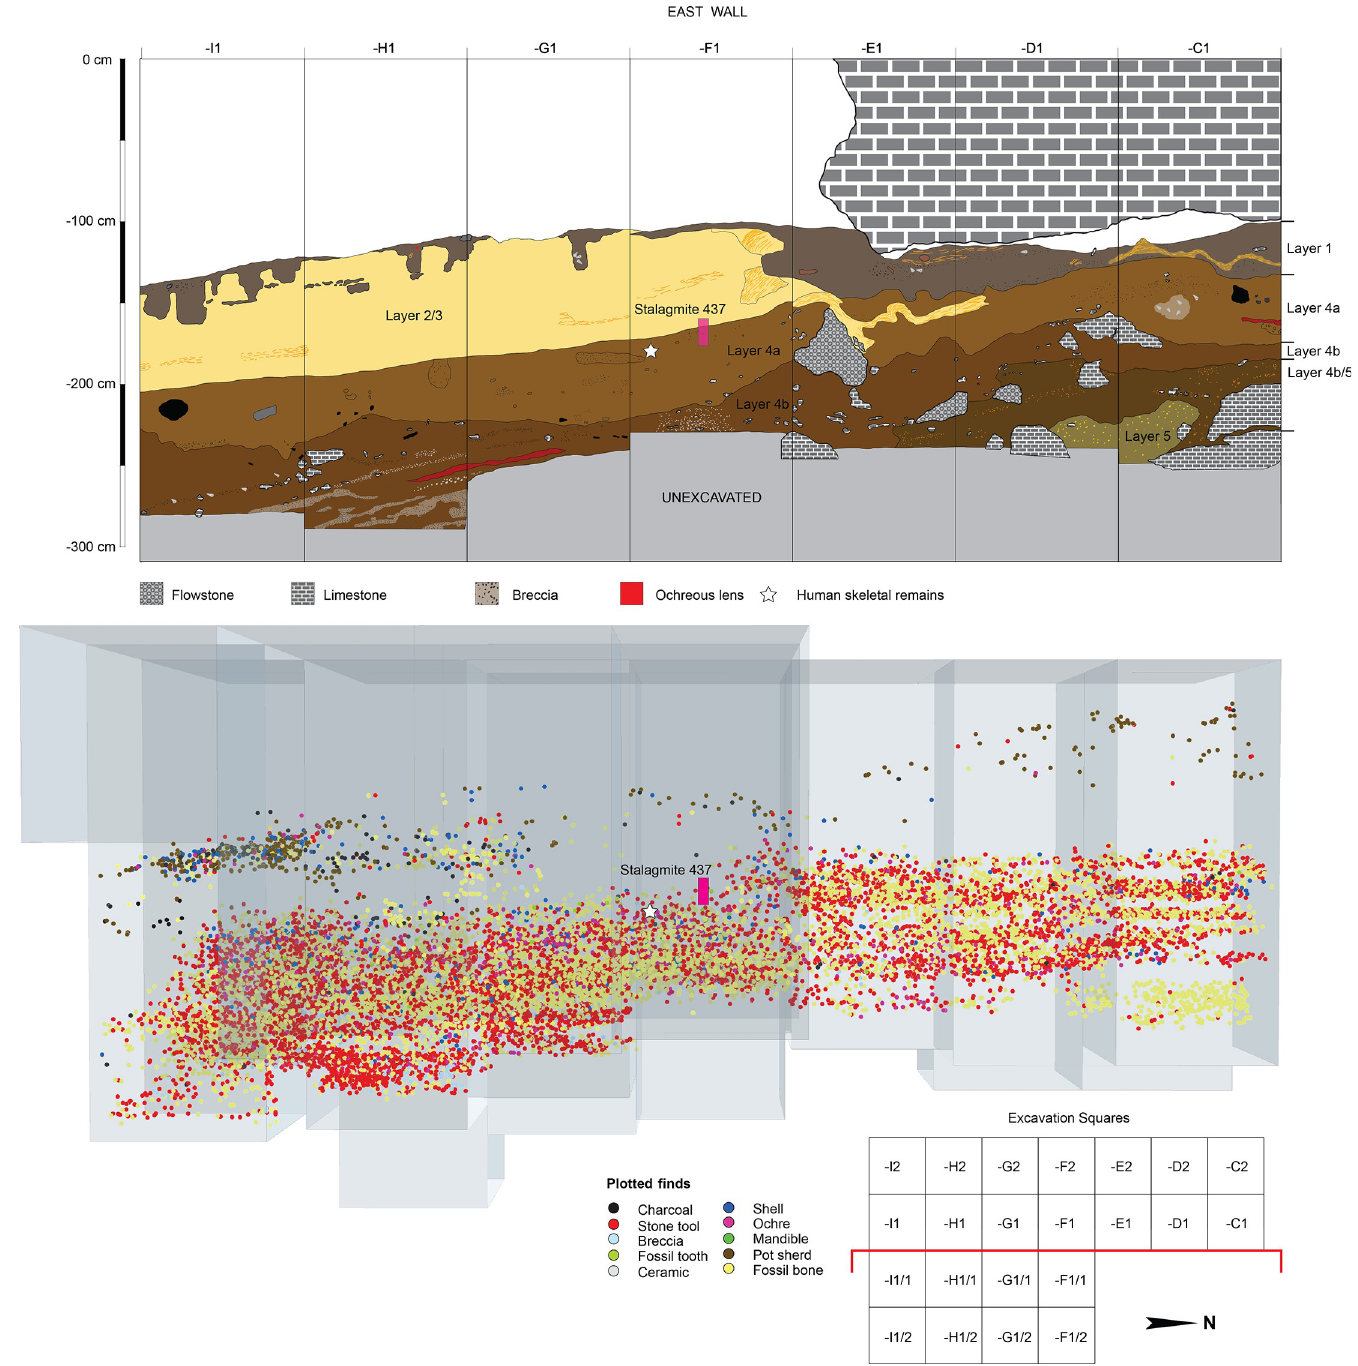
Fig 3. Stratigraphy and archaeological findings at Leang Bulu Bettue (2017). Top: East wall profile of the 2017 rock-shelter excavations, showing the stratigraphic sequence (note: Layers 4c-f are not visible here). Bottom: Spatial distribution of stone artefacts, faunal remains, and other findings recovered during the 2015–17 excavations, color-coded by stratigraphic layer (prepared using ArcScene ). The location of the modern human right maxilla (Maros-LBB-1a) in relation to Stalagmite 437 is indicated by a white star.